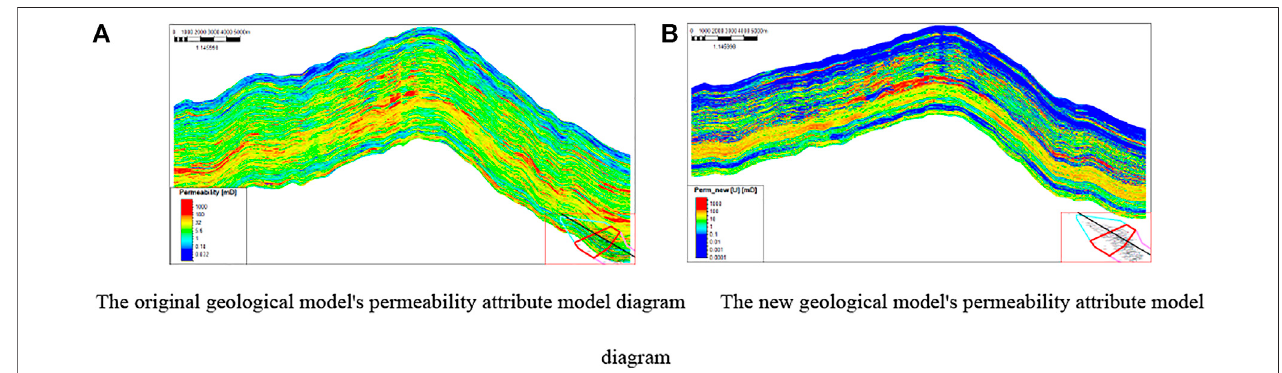
FIGURE 10 | Pro fi le of permeability model in the long axis direction of the work area. (A) The original geological model ’ s permeability attribute model diagram (B) The new geological model ’ s permeability attribute model diagram